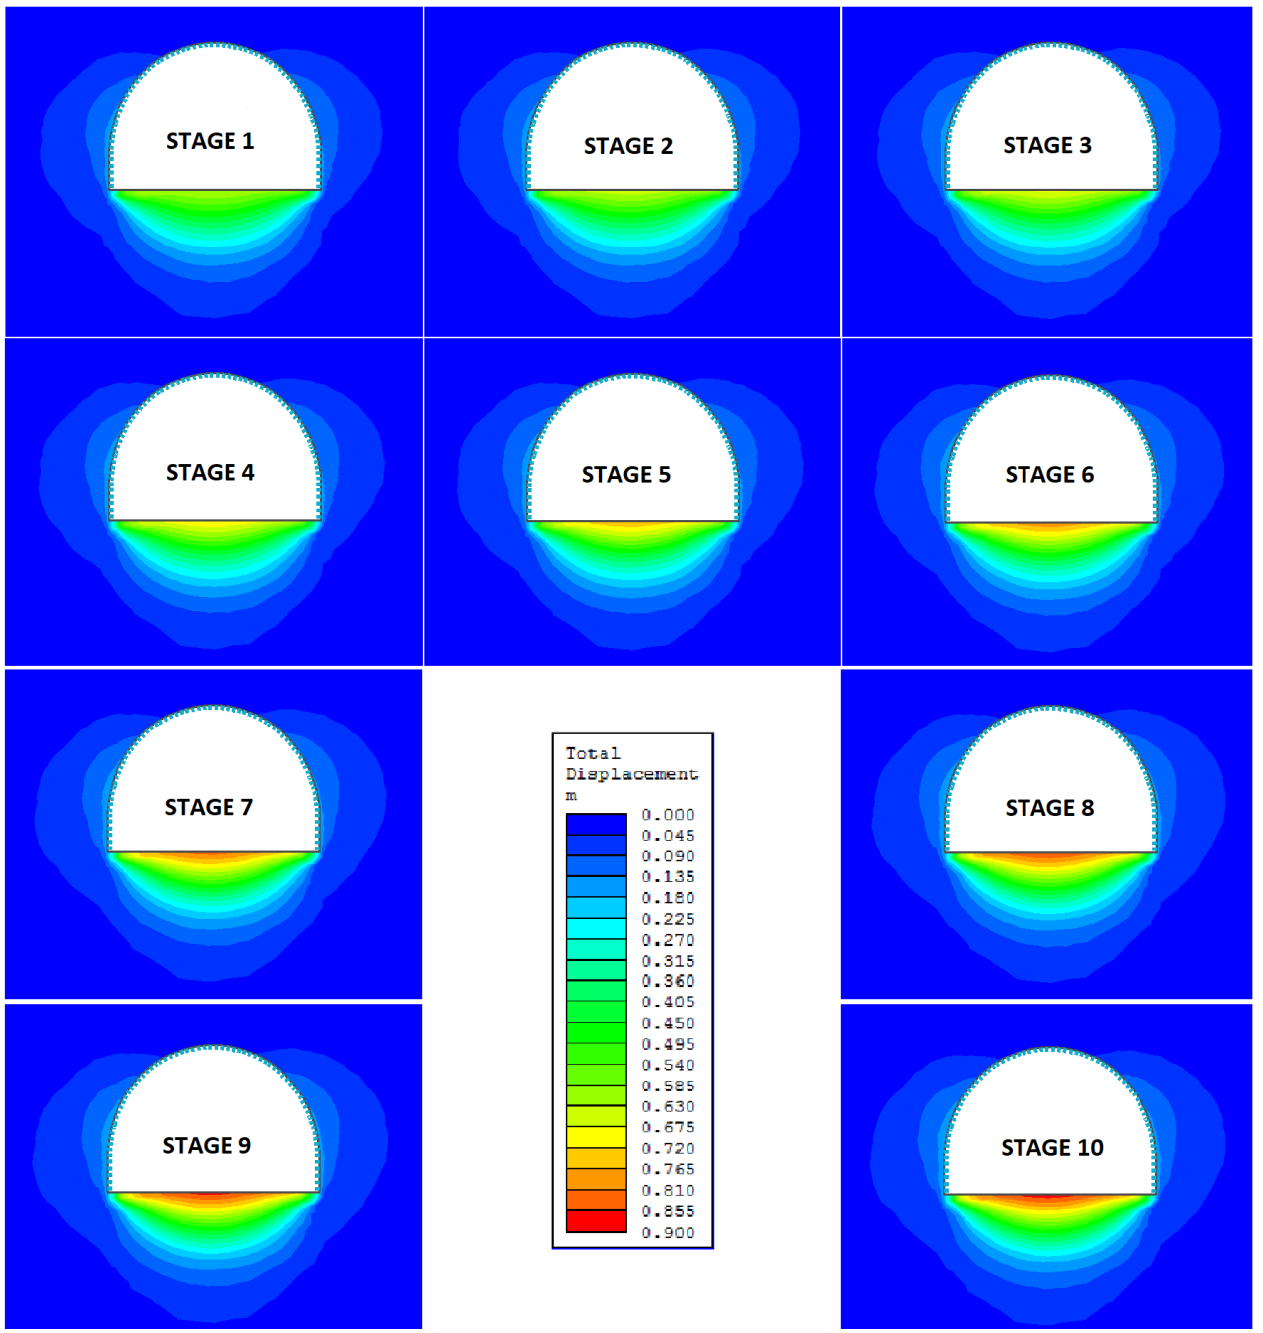
Figure 31. Convergence of roadway F-33 versus the extent of saturation zone in the floor rocks.